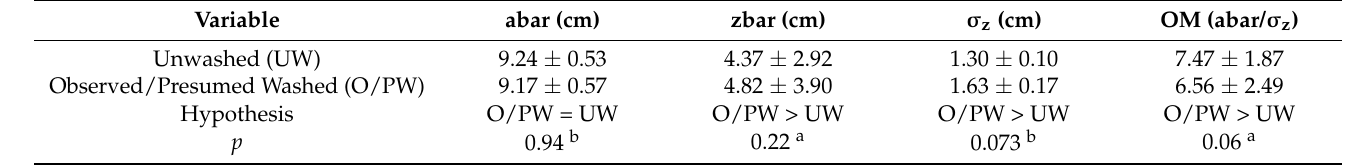
Table 7. Comparison of abar and photogrammetric digital topographic model (DTM) variables (mean ± SE) between unwashed and observed/presumed washed sites. Resampling comparison of means. Variance measures: a = standard deviation; b = standard